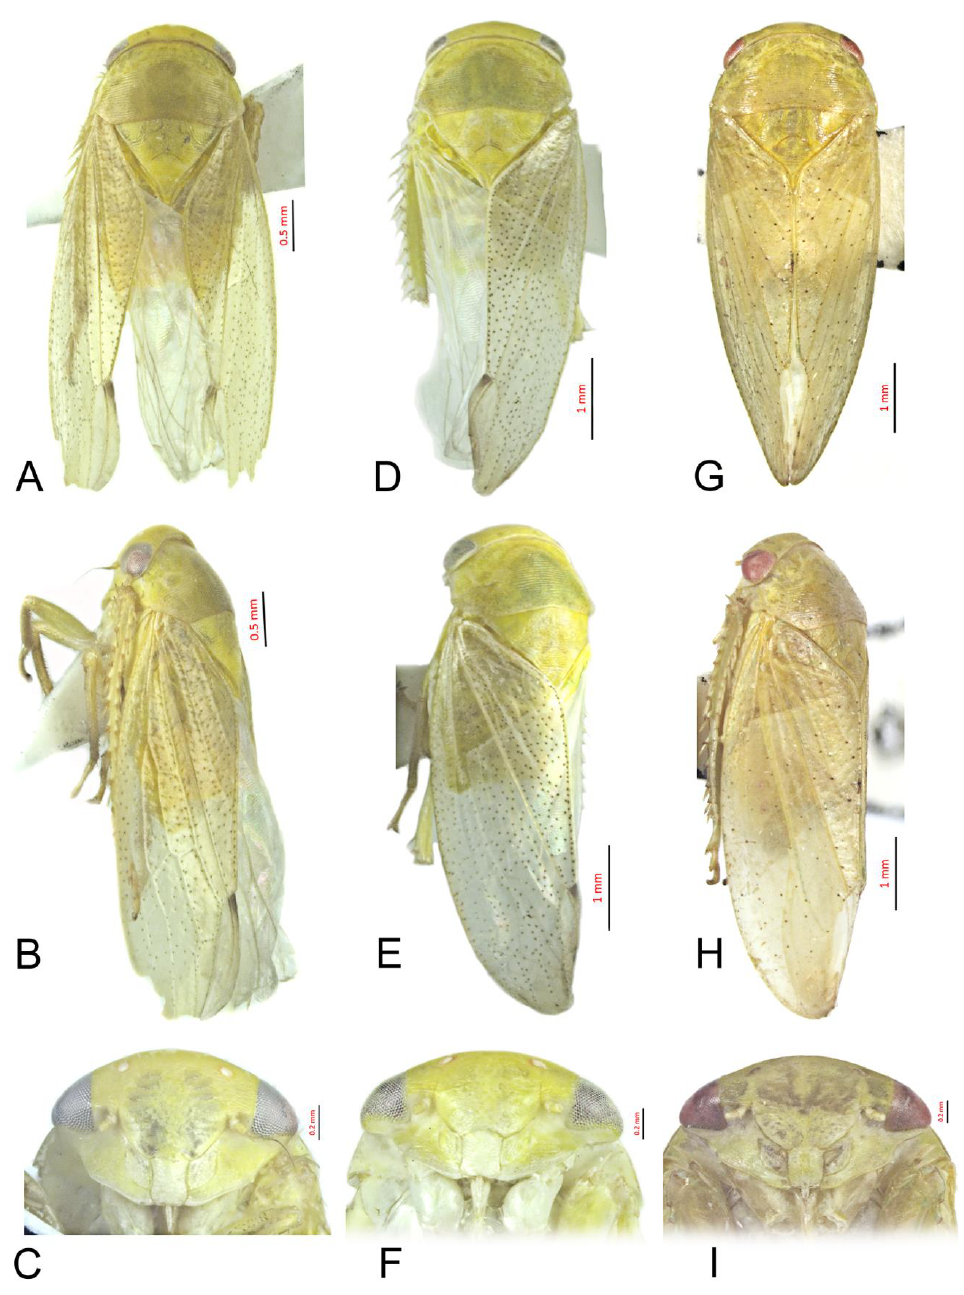
Figure 3. Batracomorphus juno Knight, 1983 rec. nov.: ( A ) habitus, ventral view, ( B ) habitus, lateral view, ( C ) face; Batracomorphus fletcheri sp. nov.: ( D ) habitus, ventral view, ( E ) habitus, lateral view, ( F ) face; Batracomorphus lateprocessus Li and Wang, 2003: ( G ) habitus, ventral view, ( H ) habitus, lateral view, ( I ). face.